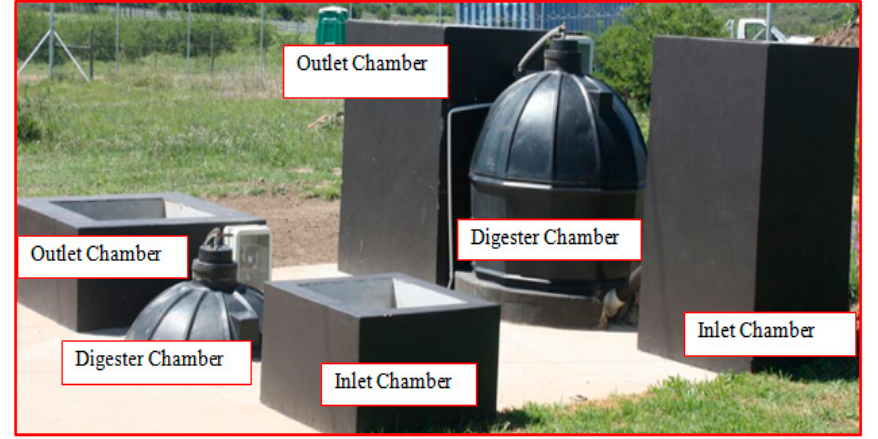
Figure 1. The biogas digester setup (The study focused on the underground digester system).